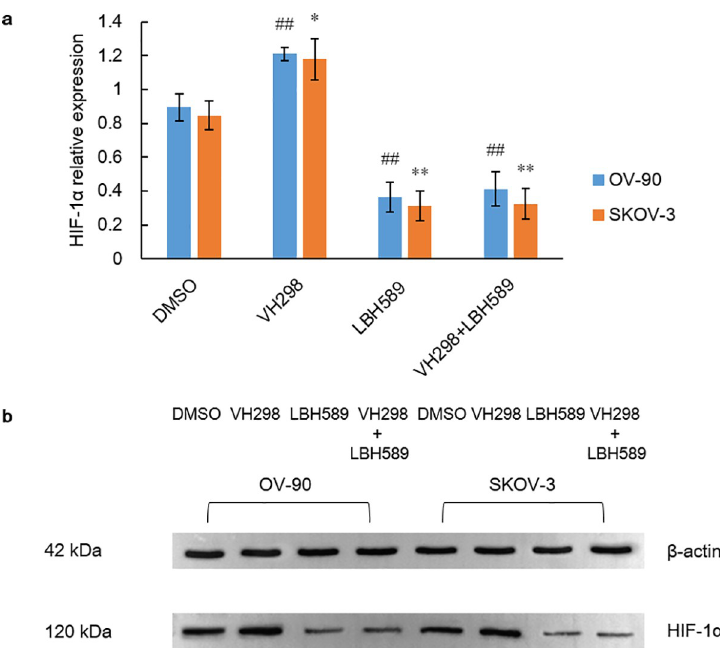
Fig 6. HIF-1 α expression after treatment of LBH589 or VH298 for 48 h. A) HIF-1 α expressions in OV-90 and SKOV-3 ovarian cancer cell lines were assessed after treatment of DMSO (control), VH298 (10 μ M), LBH589 (100 nM), and VH298 (10 μ M) + LBH589 (100 nM) for 48 h. Data are shown as mean ± SD of at least three individual experiments. ( � P < 0.05, �� P < 0.01, ��� P < 0.001 vs. SKOV-3 control (0.1% DMSO); # P < 0.05, ## P < 0.01, ### P < 0.001 vs. OV-90 control (0.1% DMSO)). B) The expression of HIF-1 α was assessed by western blot analysis after treatment of DMSO (control), VH298 (10 μ M), LBH589 (100 nM), and VH298 (10 μ M) + LBH589 (100 nM) for 48 h. The equal protein loading is shown by detection of β -actin. The figures show representative blots which were cropped from original